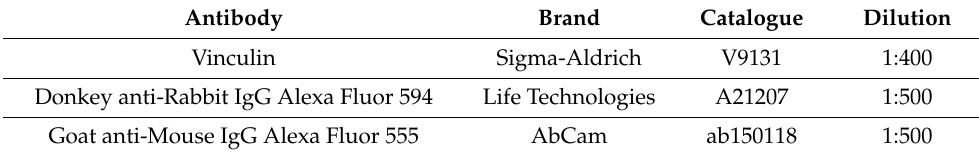
Table 2. Antibodies used for immunofluorescence.